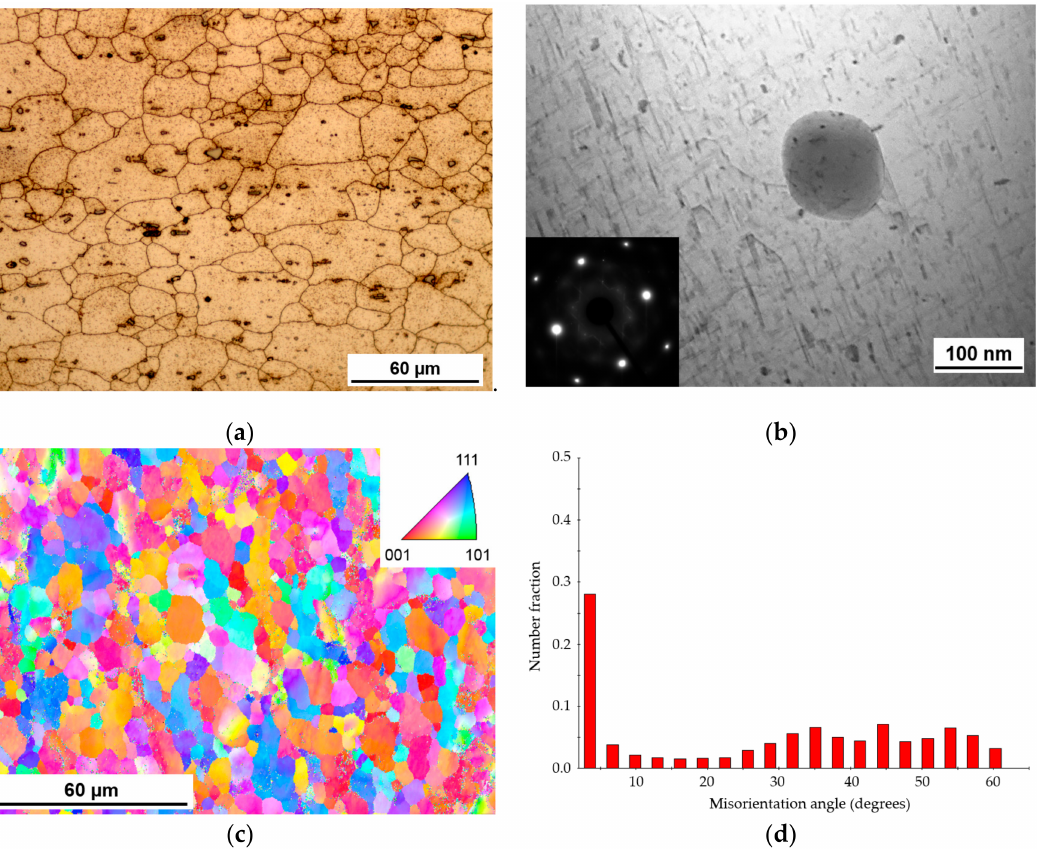
Figure 2. Microstructures of base material: ( a ) Optical image showing the grain microstructure and intermetallic compounds Al x Fe 3 MnSi 2 ; ( b ) TEM image representing high density of needle-shaped β ” phase with the corresponding diffraction pattern, and Fe-Mn-Si dispersoid; ( c ) EBSD generated IPF map; ( d ) misorientation angle